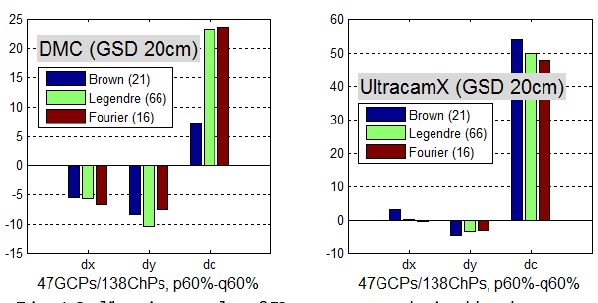
Fig. 4 Calibration results of IO parameters derived by three different APs in the blocks of DMC (left) and UltracamX (right) cameras (unit: )